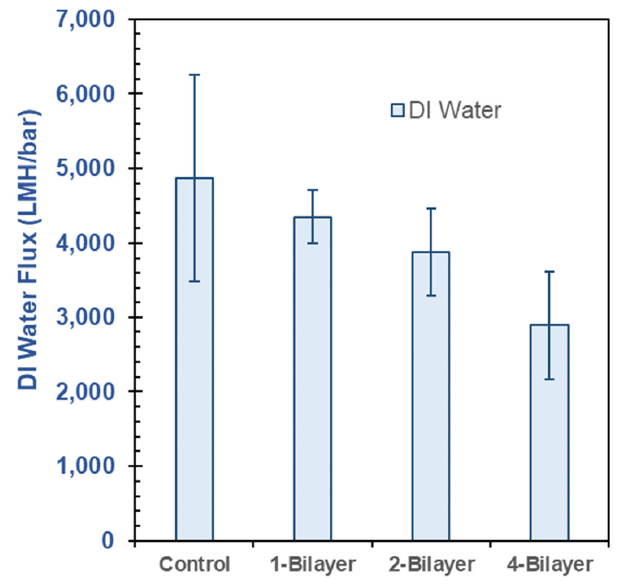
Figure 9. DI water flux performance of GO–PEI-modified CA membranes with varying bilayers.